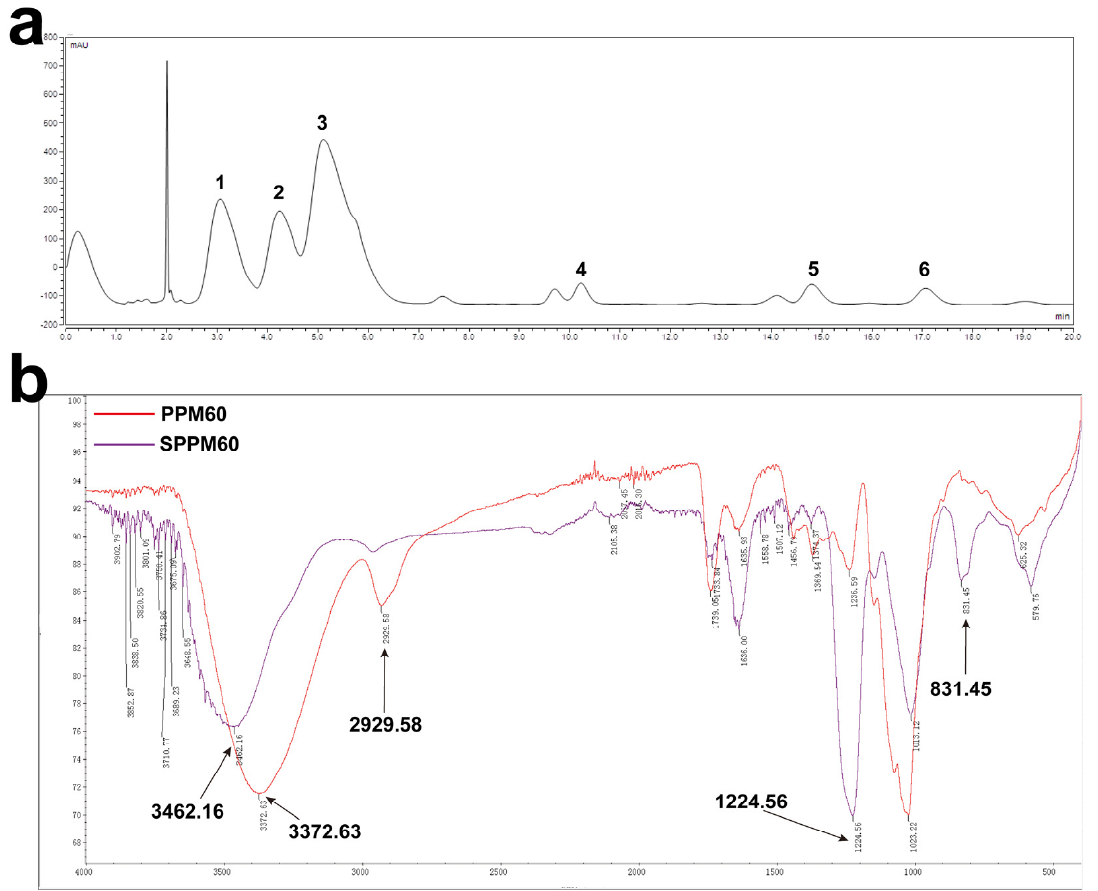
Figure 1. Extraction and sulfation of polysaccharides. ( a ) HPLC spectrum of PPM60; ( b ) infrared spectrum of PPM60 and SPPM60 sample. The numbers in the figure represent as follows: 1, galactose; 2, glucose; 3, xylose; 4, mannose; 5, rhamnose; 6, unknown.